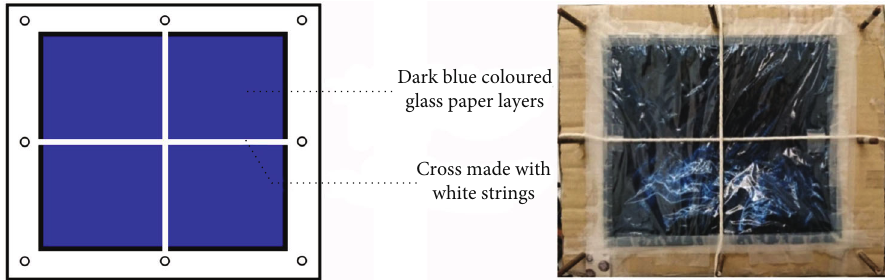
Figure 12: Accuracy measurement experiments replace Fresnel lens with cellophane papers.